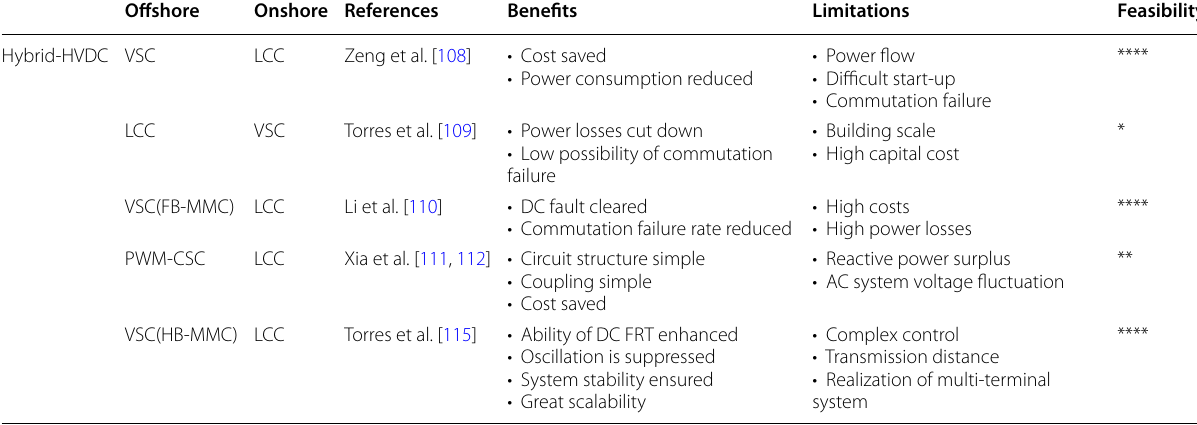
Table 5 Topology of hybrid HVDC for OWFs